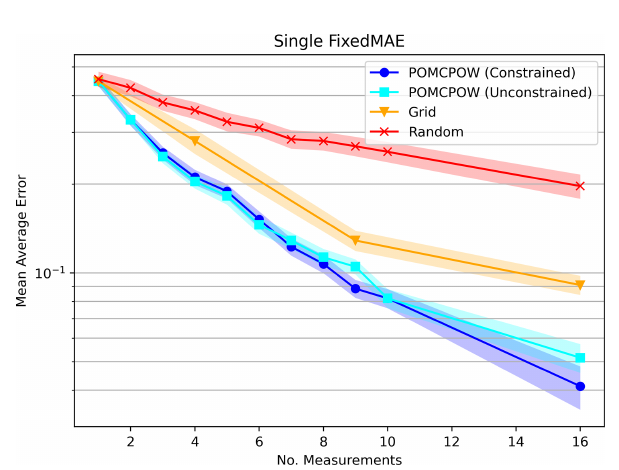
Figure 14. Single-body, fixed-location standard deviation ratios. The plot shows the mean standard deviation ratio after a given num- ber of measurements taken under each tested method. The mean ratio is shown along with 1 standard error bounds for each